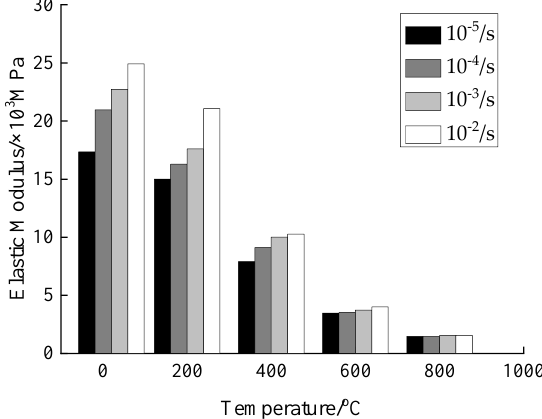
Figure 13. Elastic modulus of concrete.